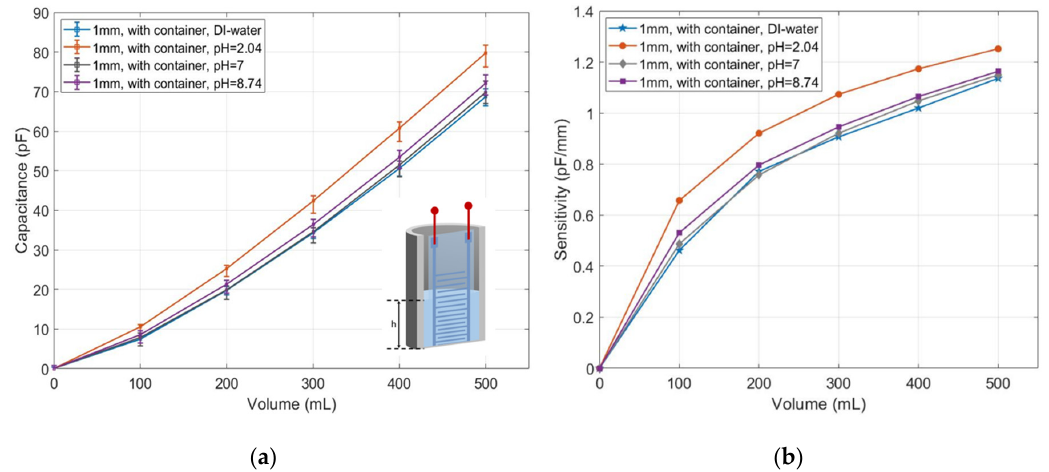
Figure 13. ( a ) Measured capacitance in response to the deionized water and buffer solutions with pH values of 2.04, 7 and 8.74; ( b ) their sensitivities.